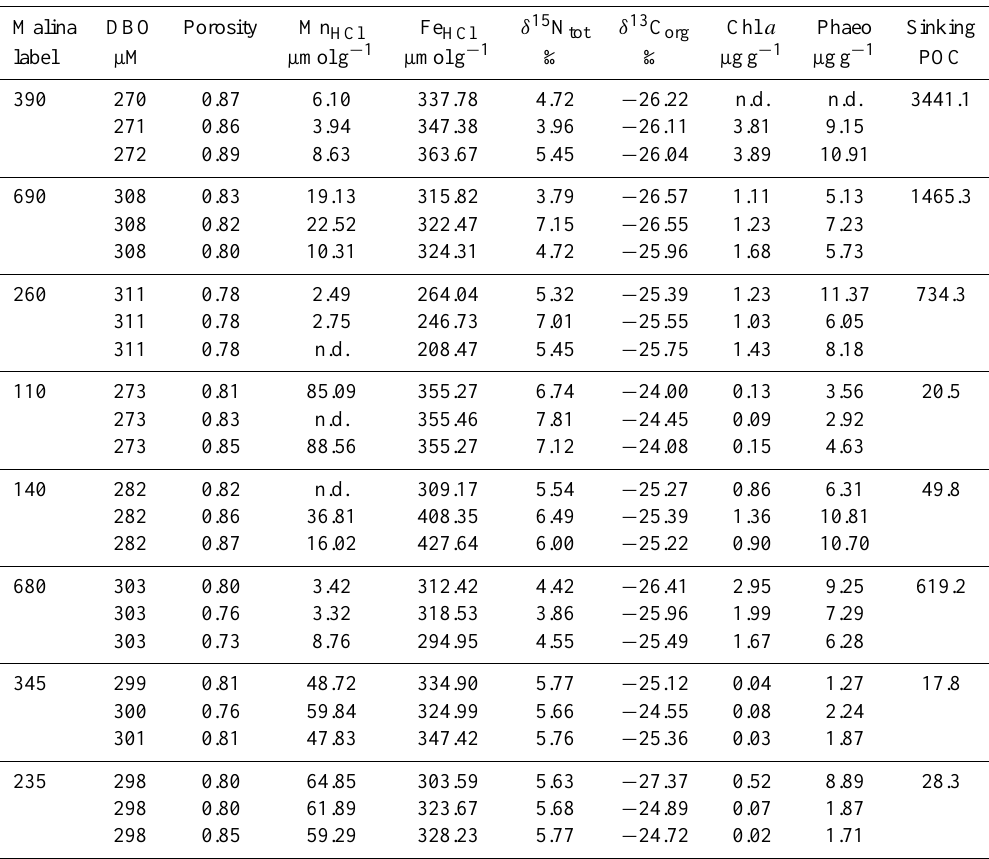
Table 4. Replicate values of abiotic parameters measured in the overlying bottom water and at the sediment surface used as environmental variables tested to explain the distribution of the benthic fluxes. Dissolved oxygen (DBO), porosity, manganese oxide (Mn HCl ) and iron oxide (Fe HCl ) contents, stable isotope signature of the surficial organic matter ( δ 13 C org ), and pigment (Chl a and phaeopigments Phaeo) contents are presented. Sinking POC estimated at the bottom of the water column by Forest et al. (2013).